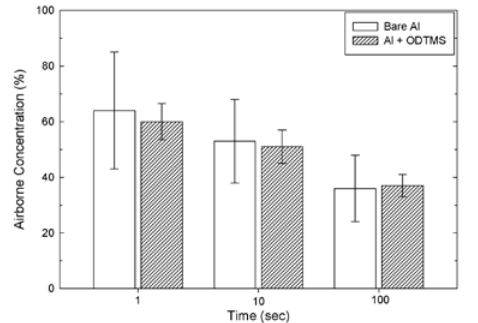
Airborne concentration of surface modified aluminum flakes at 50% humidity. The plot shows the airborne concentration of bare aluminum flakes and ODTMS surface modified aluminum flakes. Surface modification does not improve dispersion over liquid CO 2 dissemination